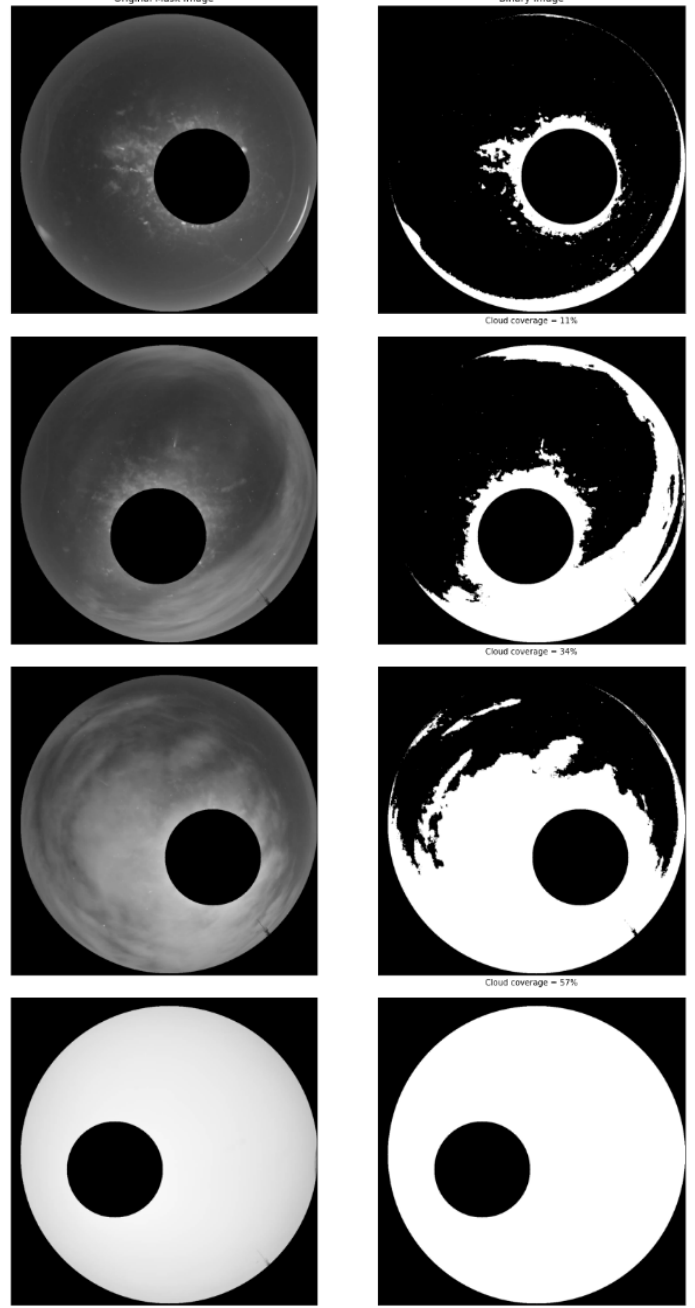
Figure 10. Four different sky conditions for MIs. ( Left ) Masked MIs. ( right ) Segmentation map, where the black color represents the regions clear of clouds and the white color corresponds to regions covered by